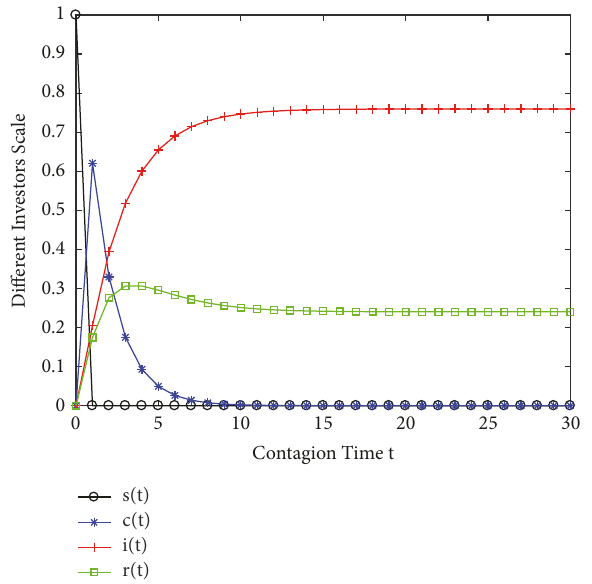
Figure 6: Change of trend of investors’ scale in different states in SCIR risk contagion model in the stock